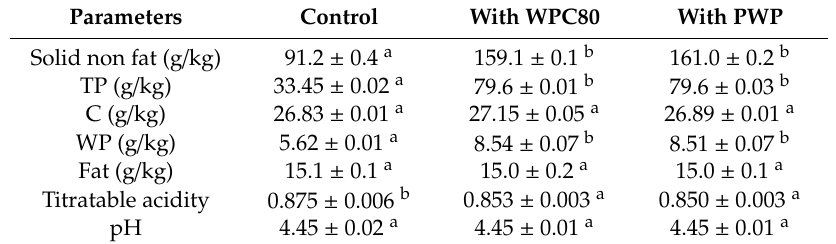
Table 2. Composition and physicochemical characteristics of yogurt with polymerized whey